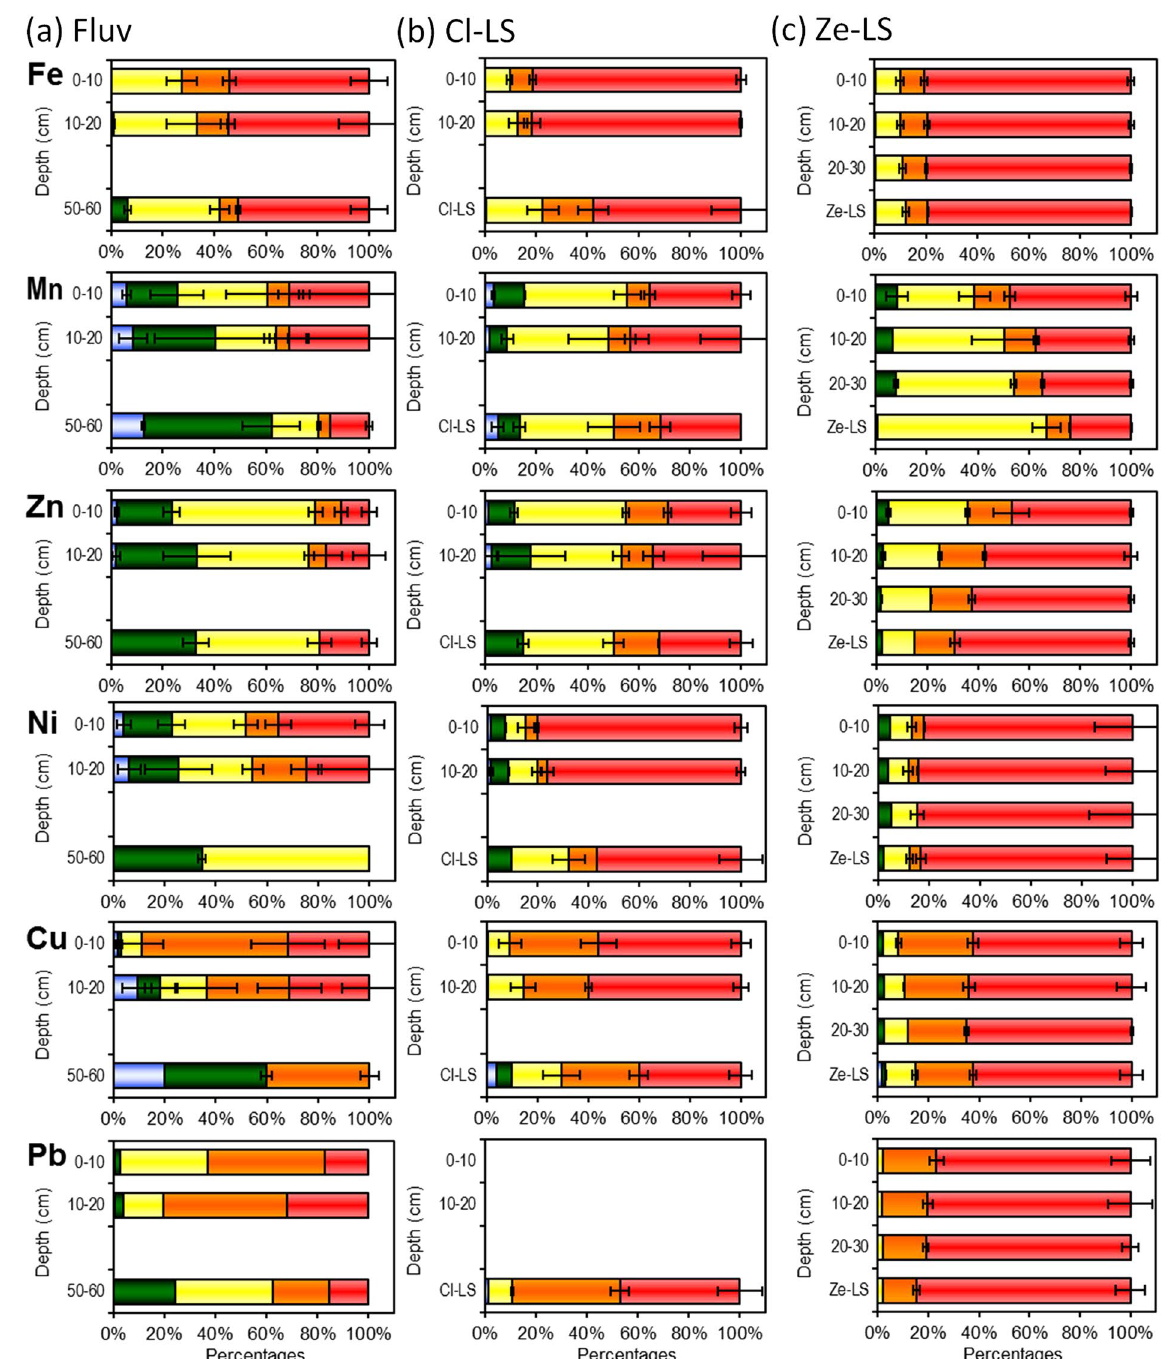
Figure 3. Relative distribution of sequential extraction-based fractions of Fe, Mn, Zn, Ni, Cu and Pb at different depths and in the corresponding starting materials of constructed wetland profiles based on ( a ) fluviatile sand (Fluv) ( b ) clinopyroxene-dominated lava sand (Cl-LS) and ( c ) zeolite-dominated lava sand (Ze-LS). : readily soluble fraction; : strongly adsorbed fraction; : reducible fraction; : oxdisible fraction; : residual fraction. Mean values and standard deviations of 2 replicates of each site together with 4 site replicates for fluviatile sites and 2 site replicates for lava sand sites are